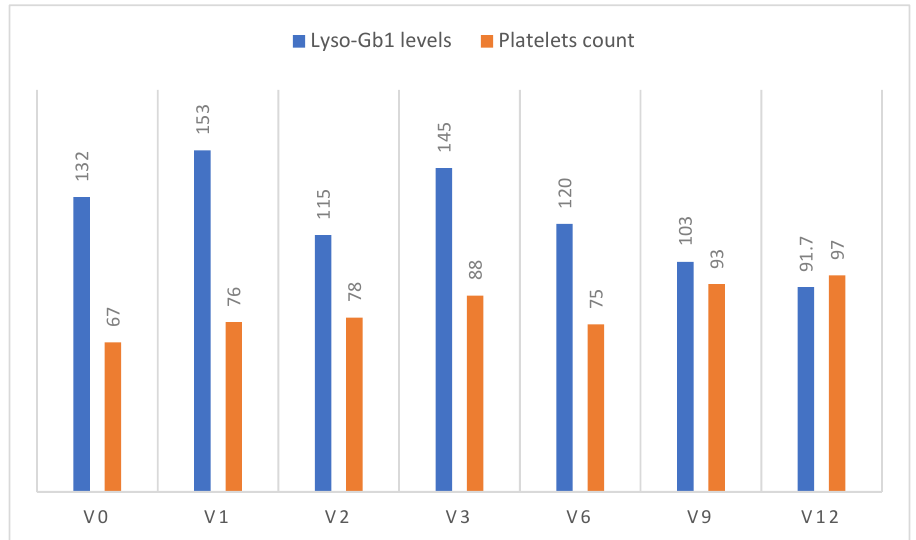
Figure 3. Changes in platelet count and Lyso-Gb1 levels from visit (V) 0 (enrollment) to the end of the study (V12) for Case